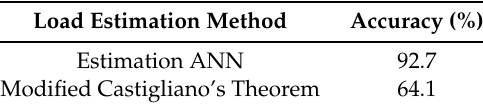
Figure 19. Load estimation based on the proposed ANN and modified Castigliano’s theorem, evaluated on test dataset. Table 6. Load estimation performance of the proposed ANN and modified Castigliano’s theorem, evaluated on the test